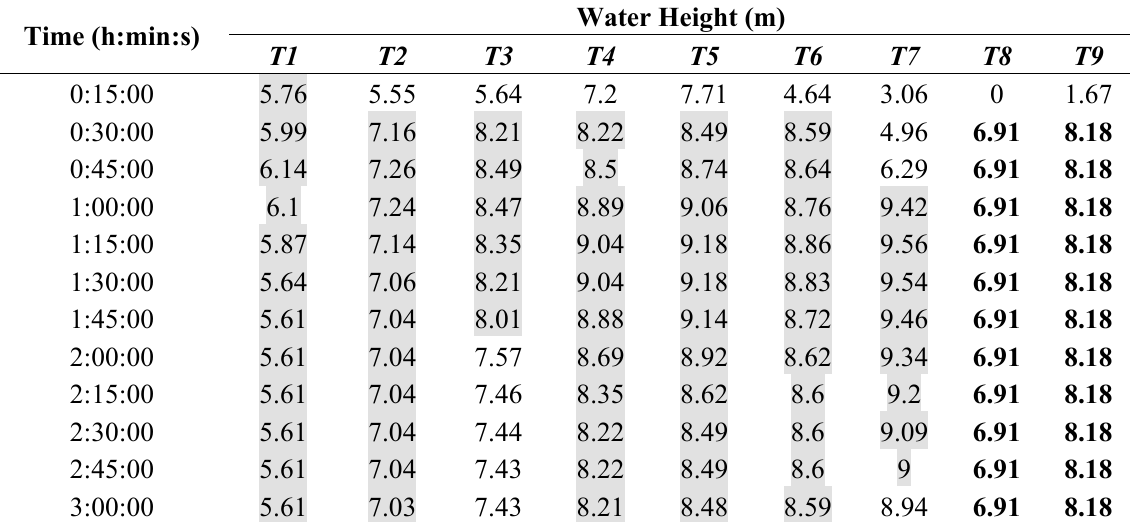
Table 1. Water heights in CSO chambers and storage tanks.